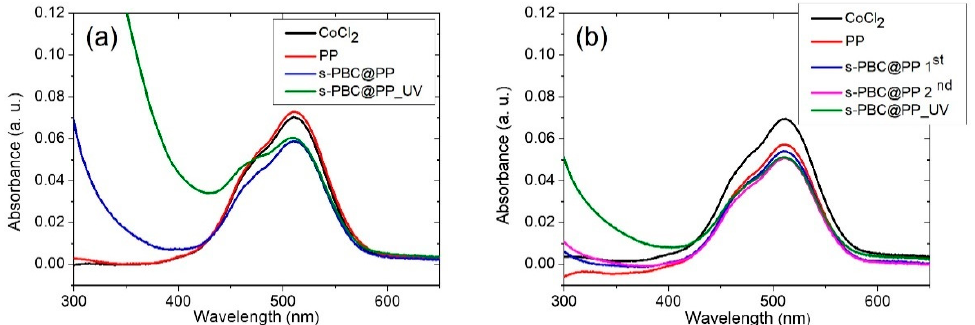
Figure 5. UV-Visible absorbance spectra of CoCl 2 solutions after ( a ) adsorption on the different filters for two hours or ( b ) filtration through them. The reference spectrum of the initial CoCl 2 solution is reported in both graphs.